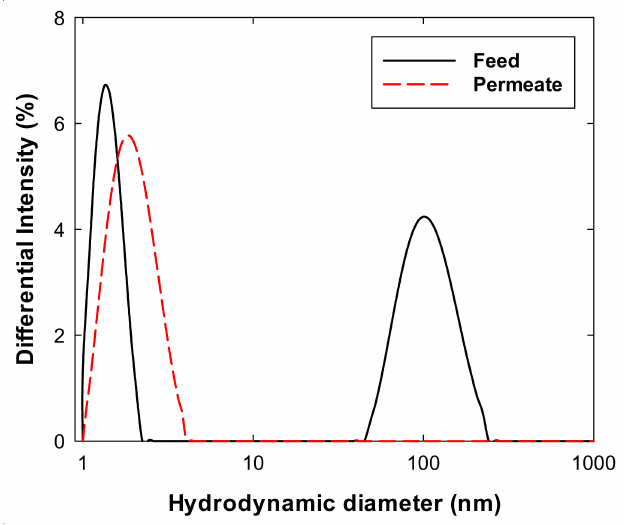
Figure 5. Hydrodynamic diameter of sucrose measured using dynamic light scattering. Feed was prepared as 20 mM histidine with 100 mM sucrose solution at pH 6 and the permeate was collected after filtration experiment.